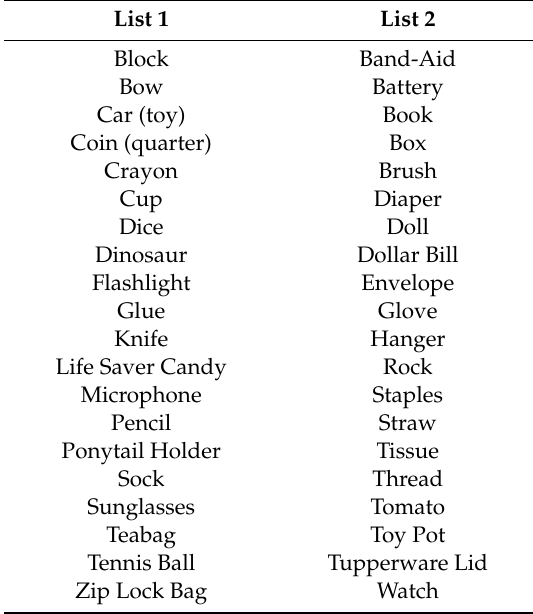
Table 1. Lists of objects presented on Visit 1 and Visit 2.